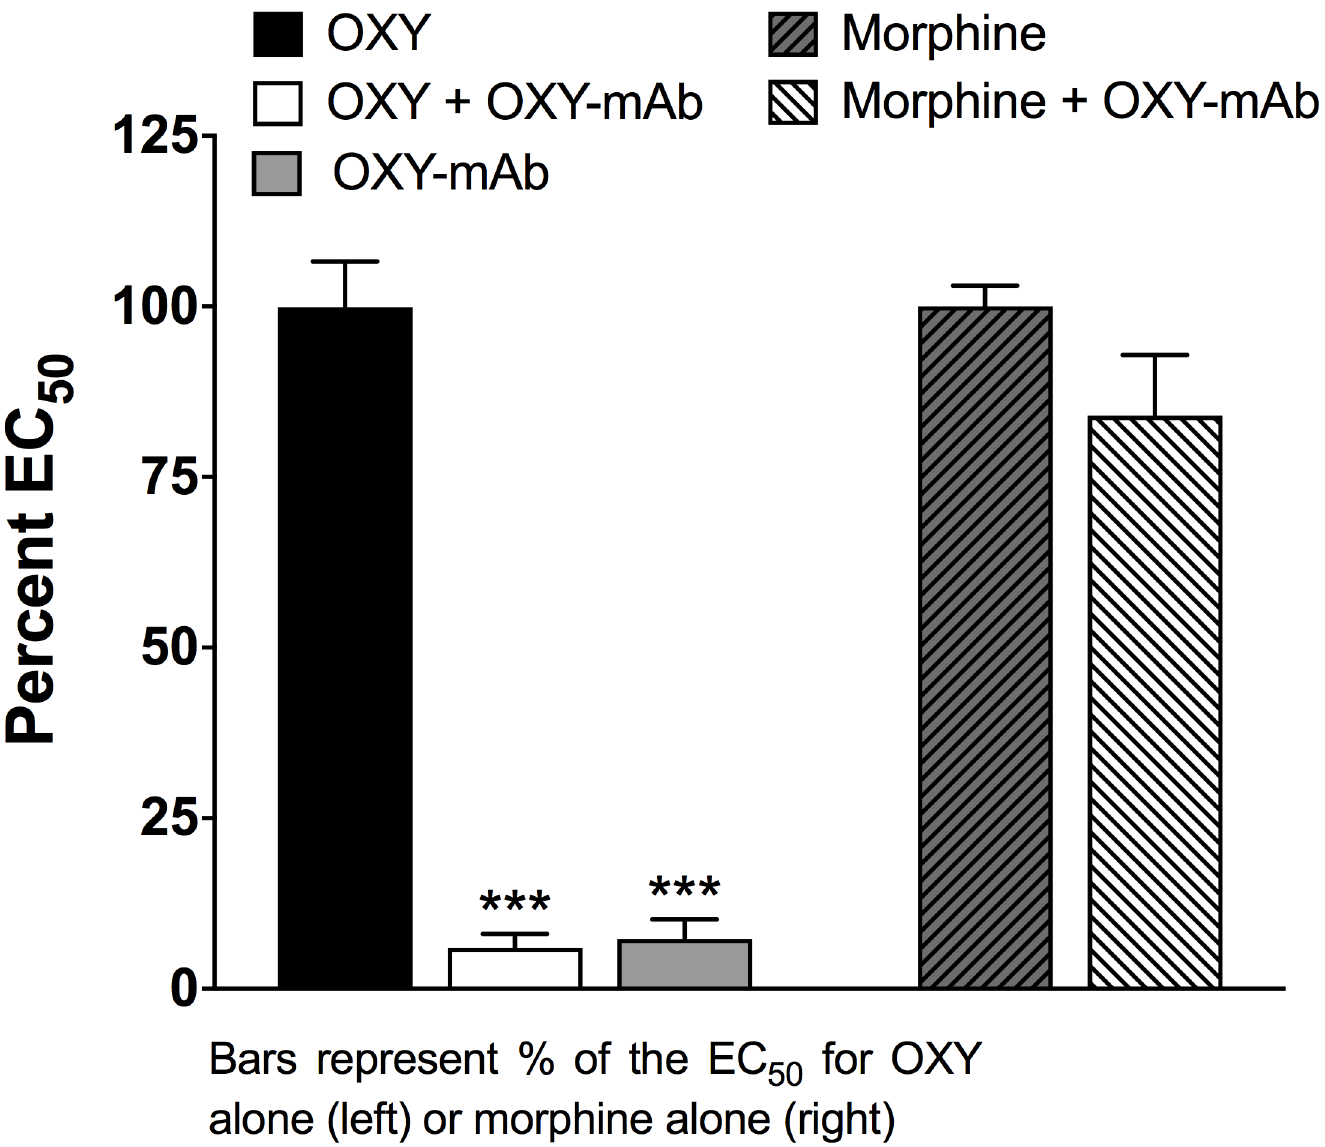
Fig 5. Oxycodone-specific monoclonal antibody prevents oxycodone-induced activation of opioid receptors. OXY-specific mAb blockedOXY- stimulatedcalcium mobilization but did not block morphine-stimulated calcium mobilization. *** P < 0.001 comparedto OXY. Bars represent the % EC 50 comparedto oxycodonealone (left) or morphinealone (right). Mean ± SEM, n = 3/group.